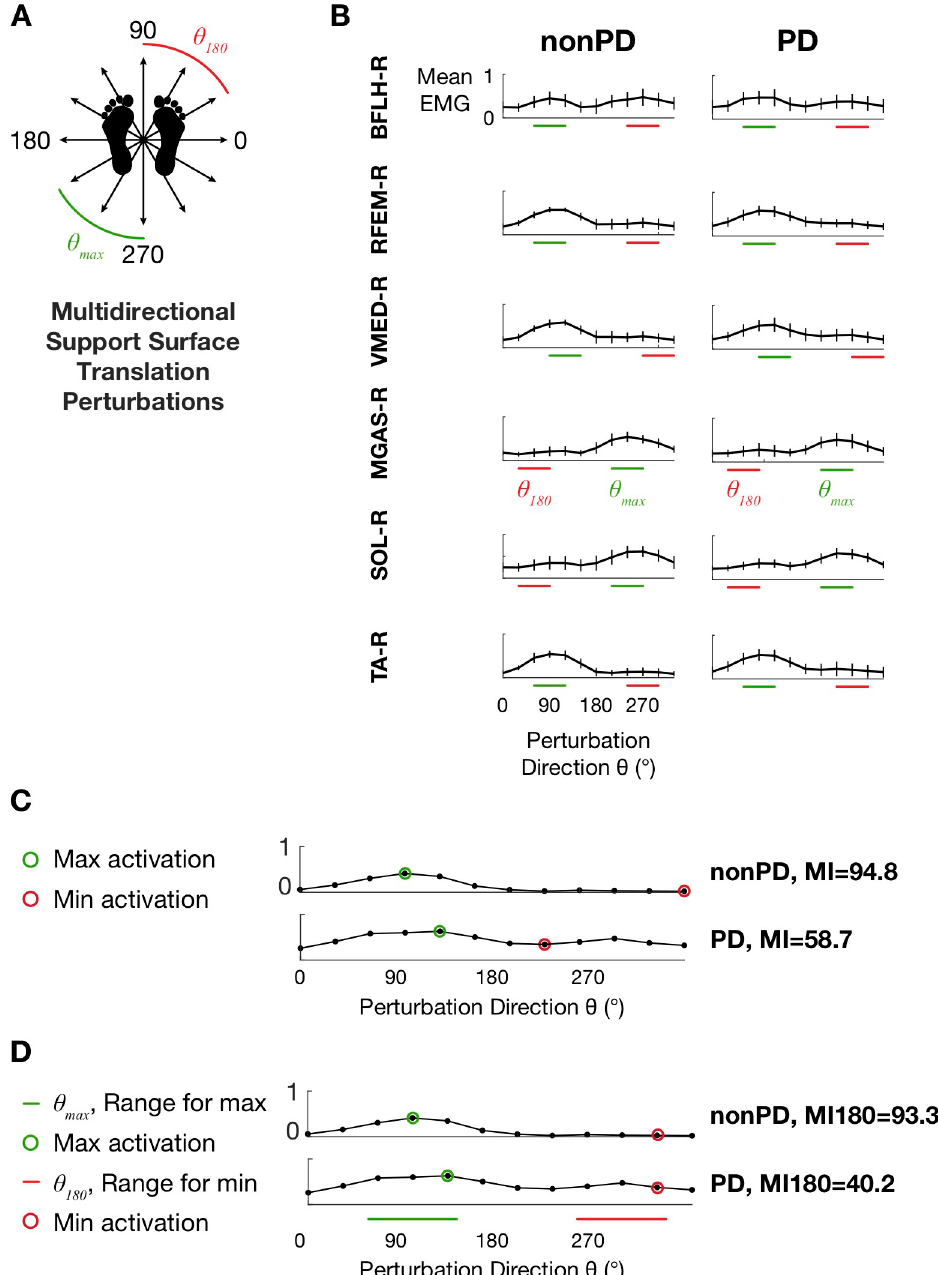
Fig 1. Translation perturbation paradigm and EMG tuning curves. A: Schematic depiction of multidirectional support surface translation perturbations. Green and red perturbation directions correspond to those for which maximum values were observed most frequently for MGAS-R and those directly opposite (see D). B: Tuning curves from the nonPD and PD groups depicting mean EMG activity during the APRX time bin (70–450 ms after perturbation onset). Horizontal bars indicate perturbation direction ranges θ modulation index MI180. C. Examples of calculation of MI (Eq 1) and MI180 (Eq 2) for TA from two different